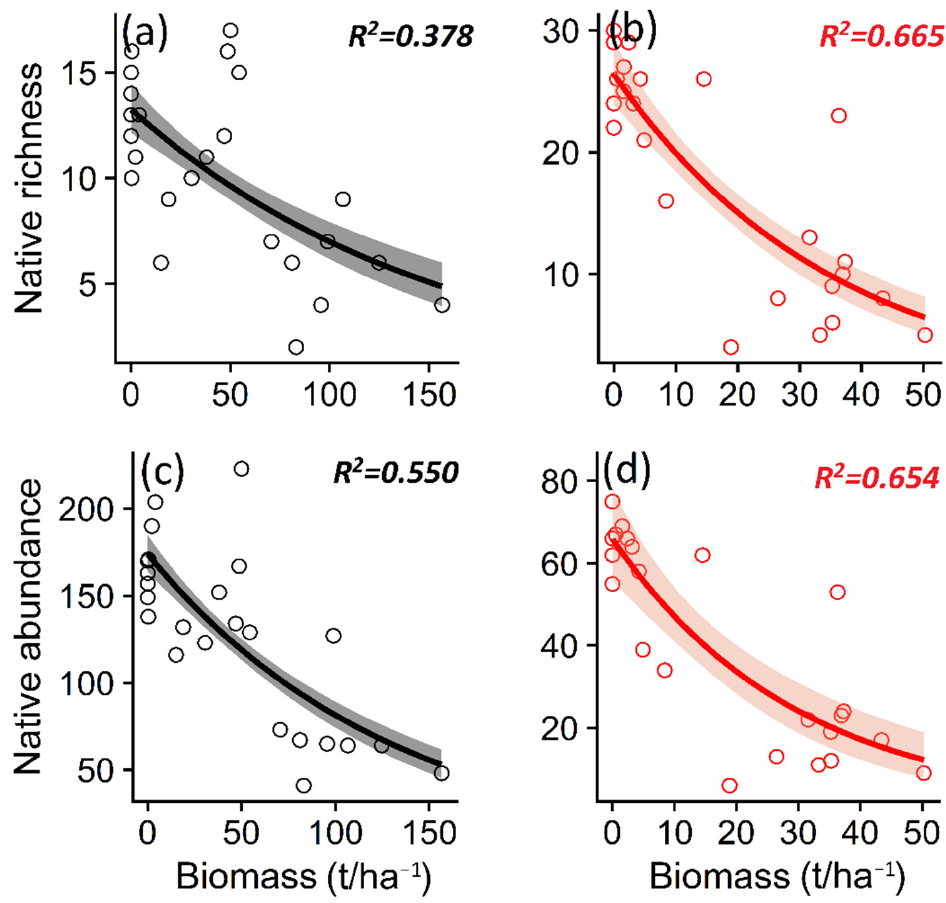
Figure 5. Relationship between the biomass of Pinus contorta in Araucaria araucana forest and Patago- nian steppe and native plant richness ( a , b ) and native plant total abundance ( c , d ). The lines show the linear model fit and the 95% confidence interval. R 2 is the adjusted R 2 .